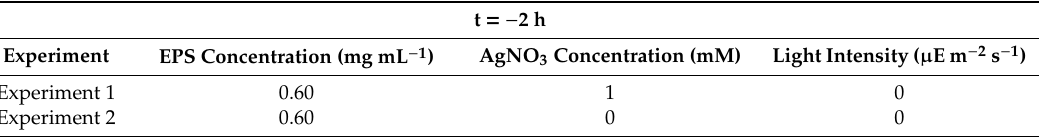
Table 4. The design of experiment starting at t = − 2